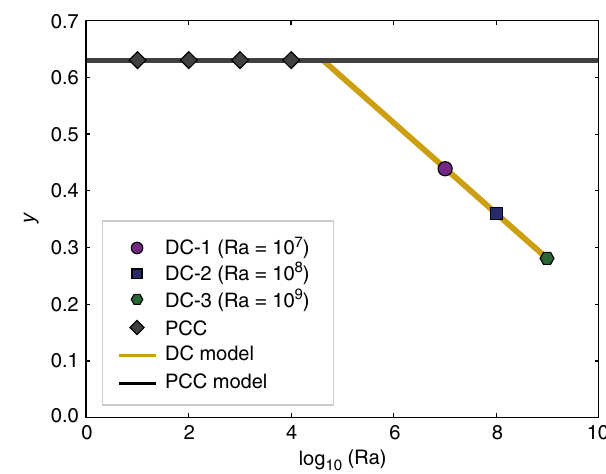
Fig. 4 Timescales of water accumulation in the melt phase. Relation between intercepts of Eqs. (1), (2), (3), and (4) and log 10 [Ra]. Data fi tting is performed with the piecewise function (5)